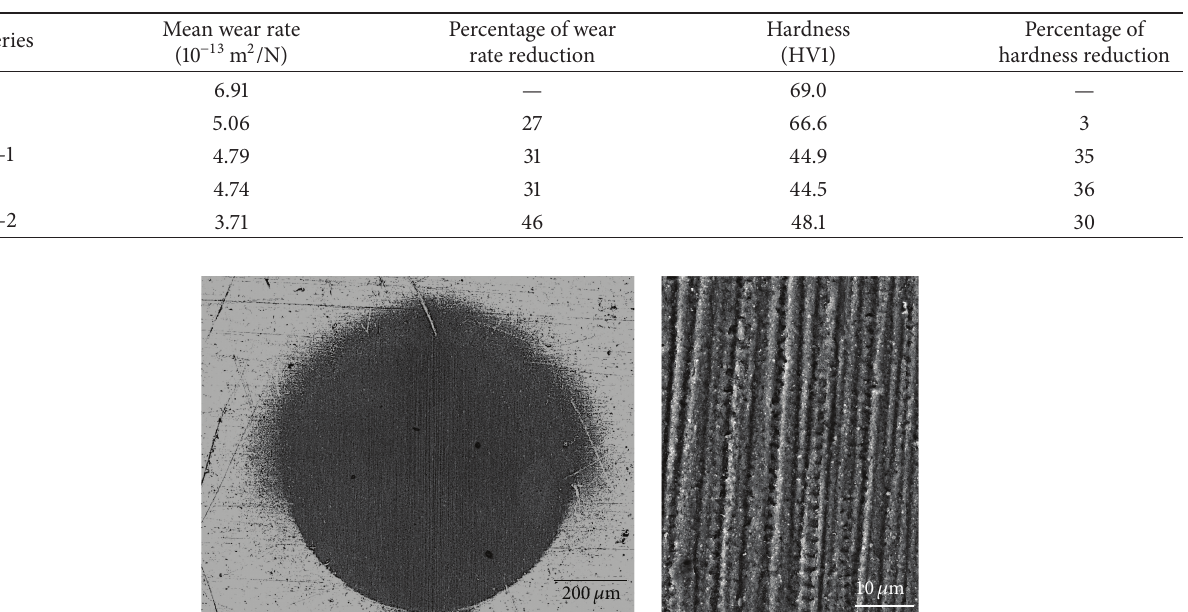
Table 3: Wear and hardness results.